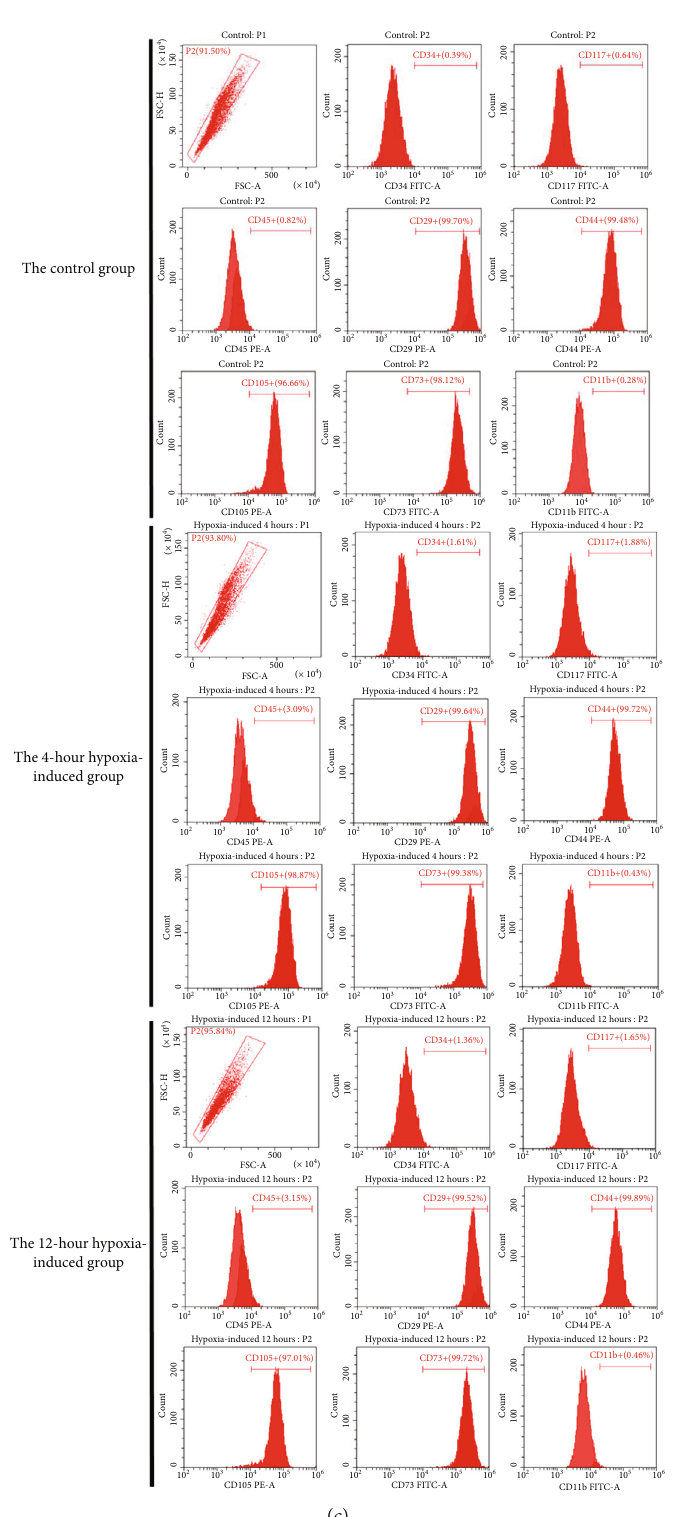
Figure 2: Hypoxia-induced cell senescence at di ff erent time points and surface marker pro fi les. (a) Representative images of senescent hBMSCs using SA- β -gal staining. Blue: SA- β -gal-positive cells. Scale bar = 100 μ m . (b) Quanti fi cation of SA- β -gal-positive cells. The percentage of SA- β -gal-positive cells was signi fi cantly increased after hypoxia treatment, compared to the control group. 0 h, 4h, and 12h: time of hypoxia treatment. Experiments were performed in three hBMSC cultures from three di ff erent donors. Mean ± SD . ∗∗ p < 0 : 01 vs. the 0 h control group. (c) The expressions of surface markers such as CD34, CD117, CD45, CD29, CD44, CD105, CD73, and CD11b were not signi fi cantly di ff erent between the hypoxia-induced group and the control